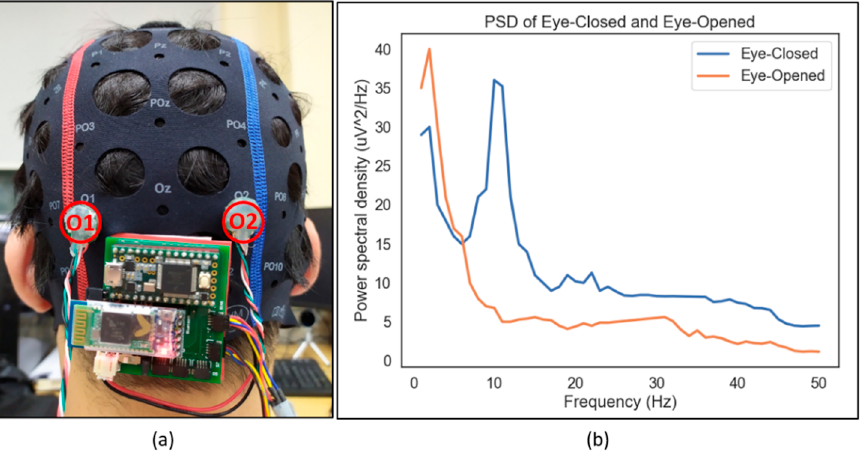
Figure 3. ( a ) Experimental setup for EEG device testing; ( b ) power spectral densities (PSDs) during eyes-closed and eyes-opened resting state from O1-O2 locations.